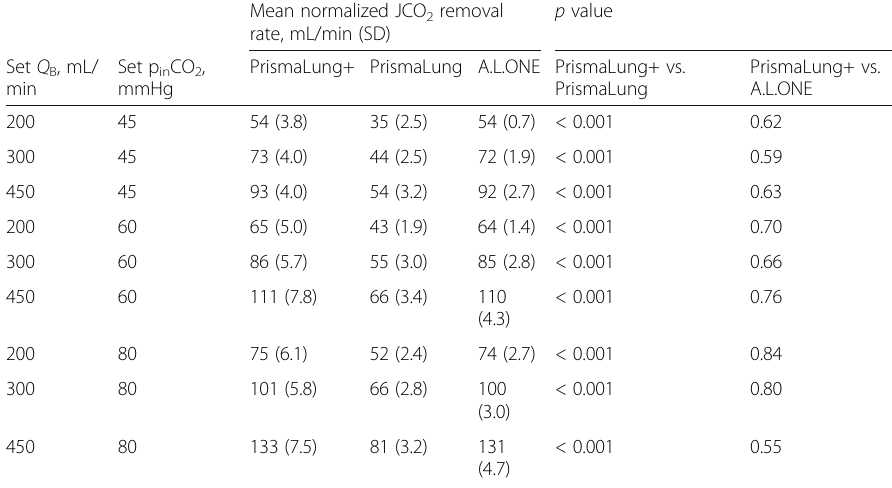
Table 4 CO 2 removal rates using the infusion method at 37 °C for PrismaLung+, PrismaLung,